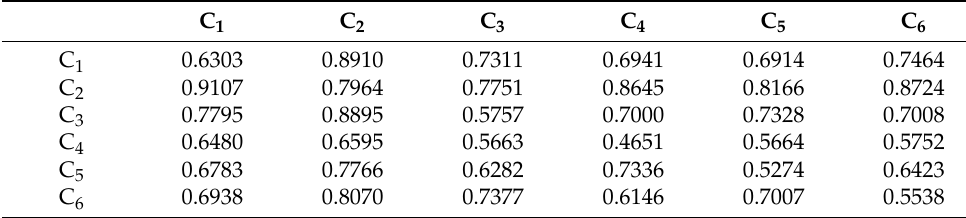
Table 3. Comprehensive influence matrix of the first-level influencing factors.